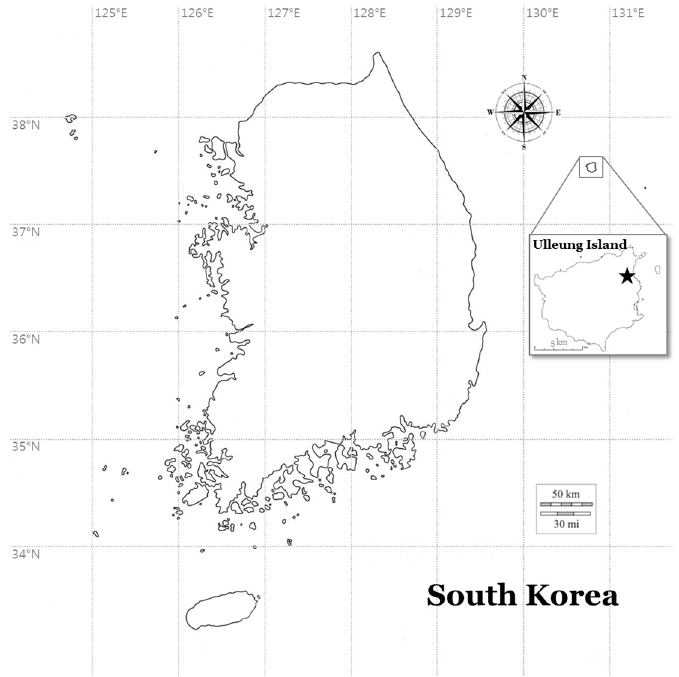
Figure 1. Specific collection site (black star mark) for the new species Arthonia ulleungdoensis .